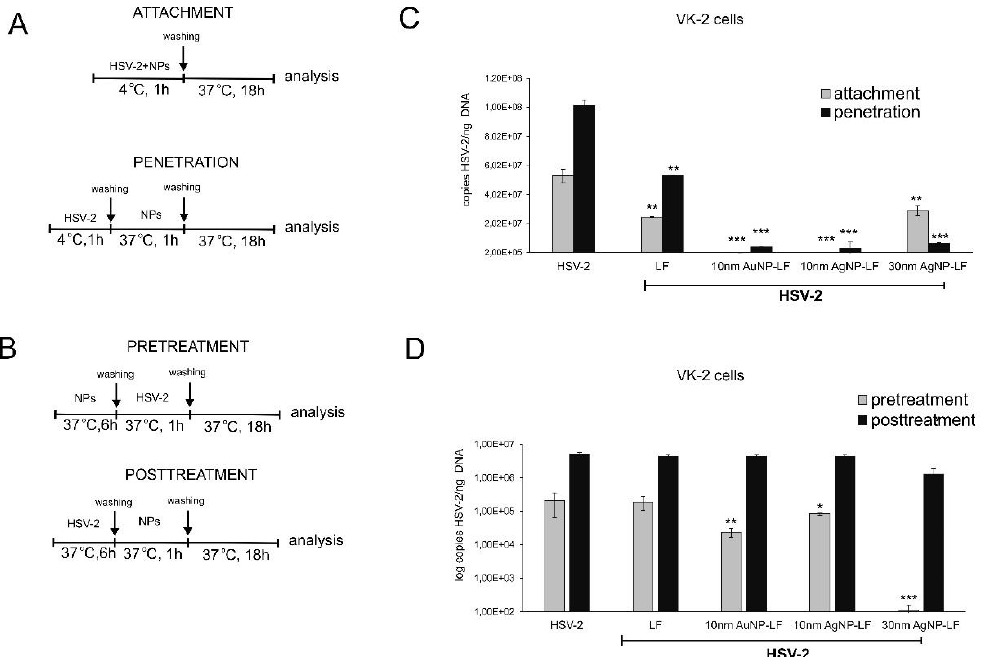
Figure 3. Lactoferrin-modified Ag/AuNPs block HSV-2 attachment and penetration in vaginal VK-2-E6/E7 keratinocytes. ( A , B ) Schematic representation of test procedures, I inhibition of